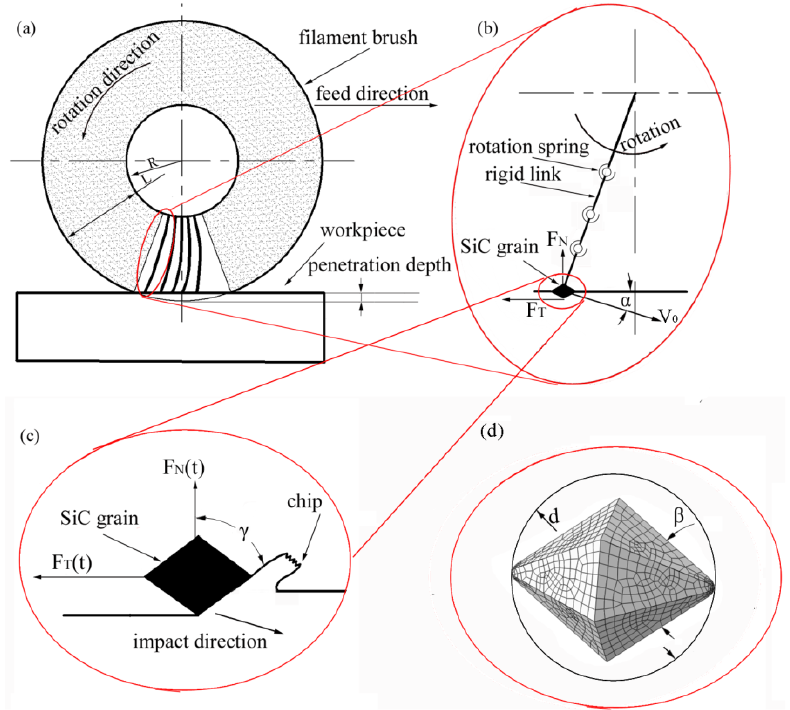
Figure 2. Brush grinding: ( a ) filament brush; ( b ) single abrasive filament; ( c ) impact phase of grain; and ( d ) the geometry of abrasive grain after meshing.